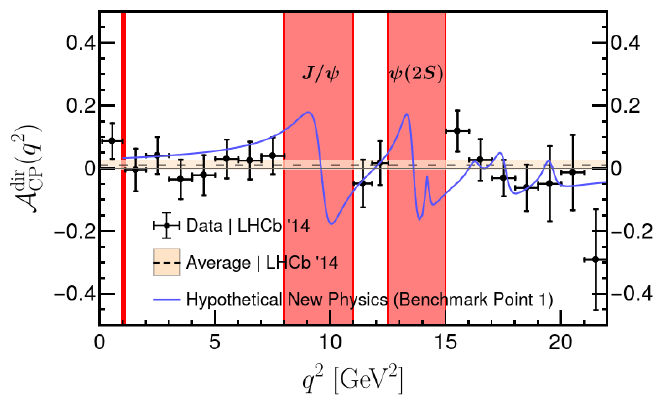
Figure 3 . Illustration of the experimental measurements of the direct CP asymmetry of B − → K − µ + µ − by the LHCb collaboration [36]. The blue line shows the prediction for Benchmark Point 1 given in (3.5) (see also [23,